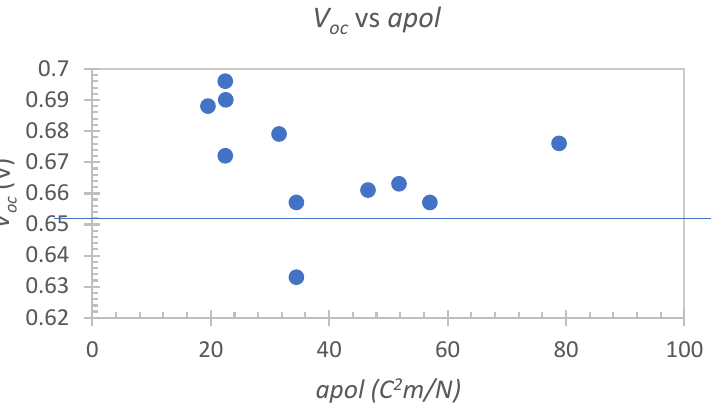
Figure 7. Exponential correlations between the counter-electrode resistance ( R Pt ) and the relative positive charge ( RPCG ), molecular polarizability ( apol ) and partition coefficient ( logP ) descriptors for the 4-TBP free set.